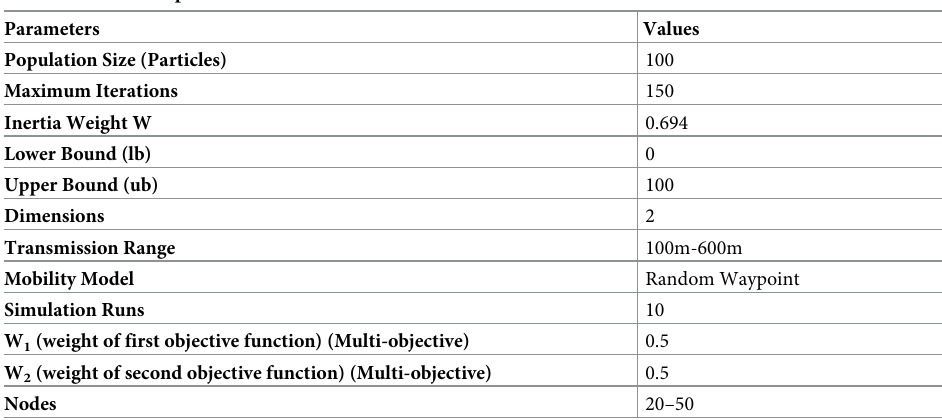
Table 2. Simulation parameters.